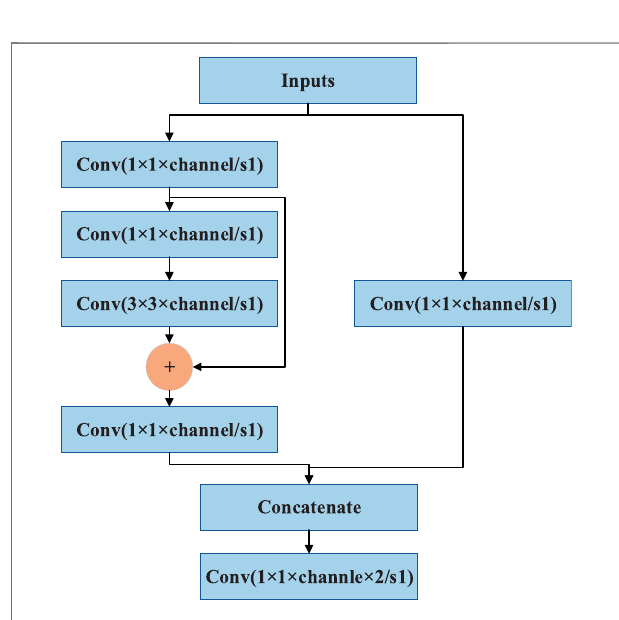
FIGURE 2 | ResBlock module